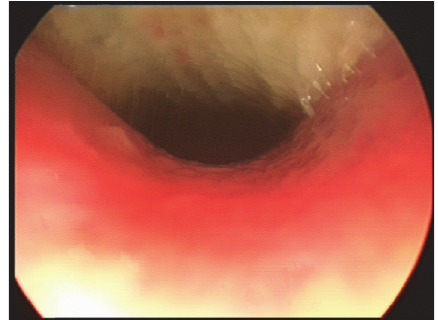
Figure 1: View of the trachea during bronchoscopy. Note the obstruction of > 50% of the tracheal lumen by whitish thick secre- tions.